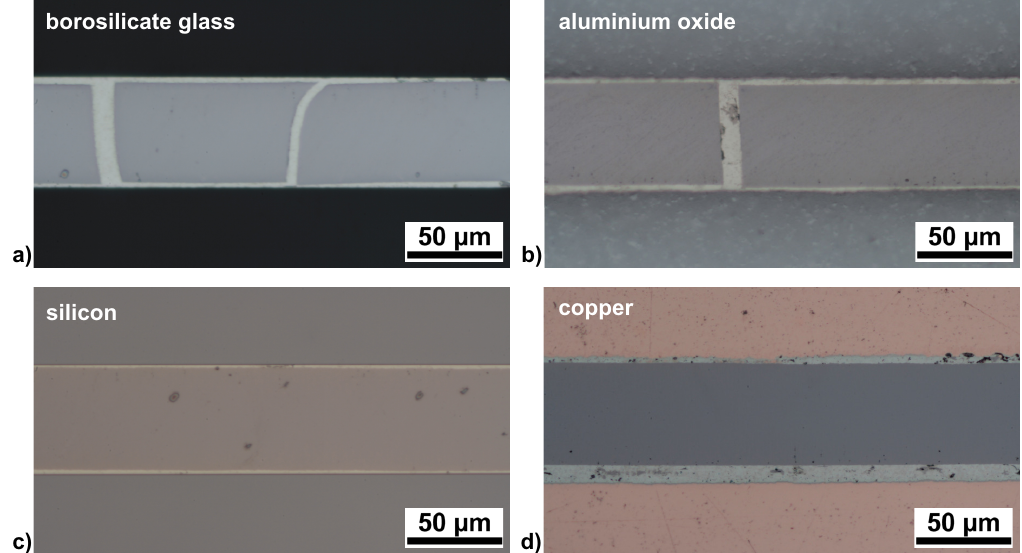
Figure 3. Cross-sections (optical microscopy) of joints prepared by reactive joining for ( a ) borosilicate glass; ( b ) Al 2 O 3 ; ( c ) Si; and ( d ) Cu. The micrographs were recorded in pore-free regions of the solder layers (cf. the CT results shown in Figure